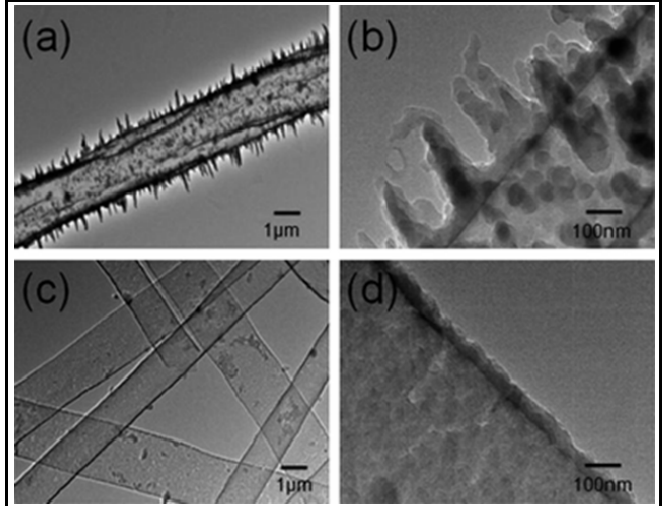
Figure 21. TEM images of ( a , b ) burr-shaped PPy hollow fibers polymerized under mechanical stirring and ( c , d ) PPy hollow fibers polymerized under ultrasonication. Reprinted with permission from [76]. Copyright 2012 Royal Society of